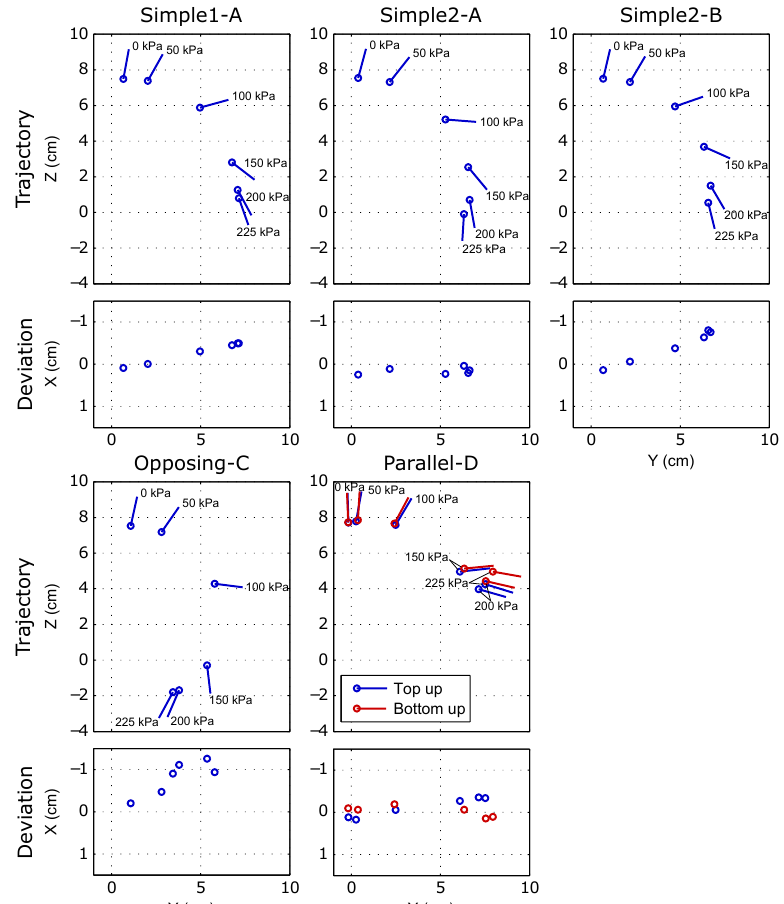
Figure 6. Flexion trajectory results, showing the motion of the actuator tip vector formed by two markers. Only the Simple2-A and Parallel-D prototypes stayed in a relatively straight trajectory. The others tended to turn to the left. Lengthwise extension is visible as the tip marker’s deviation from a round trajectory. For Parallel-D, it is possible to see an end of the flexion motion, after which only lengthwise extension